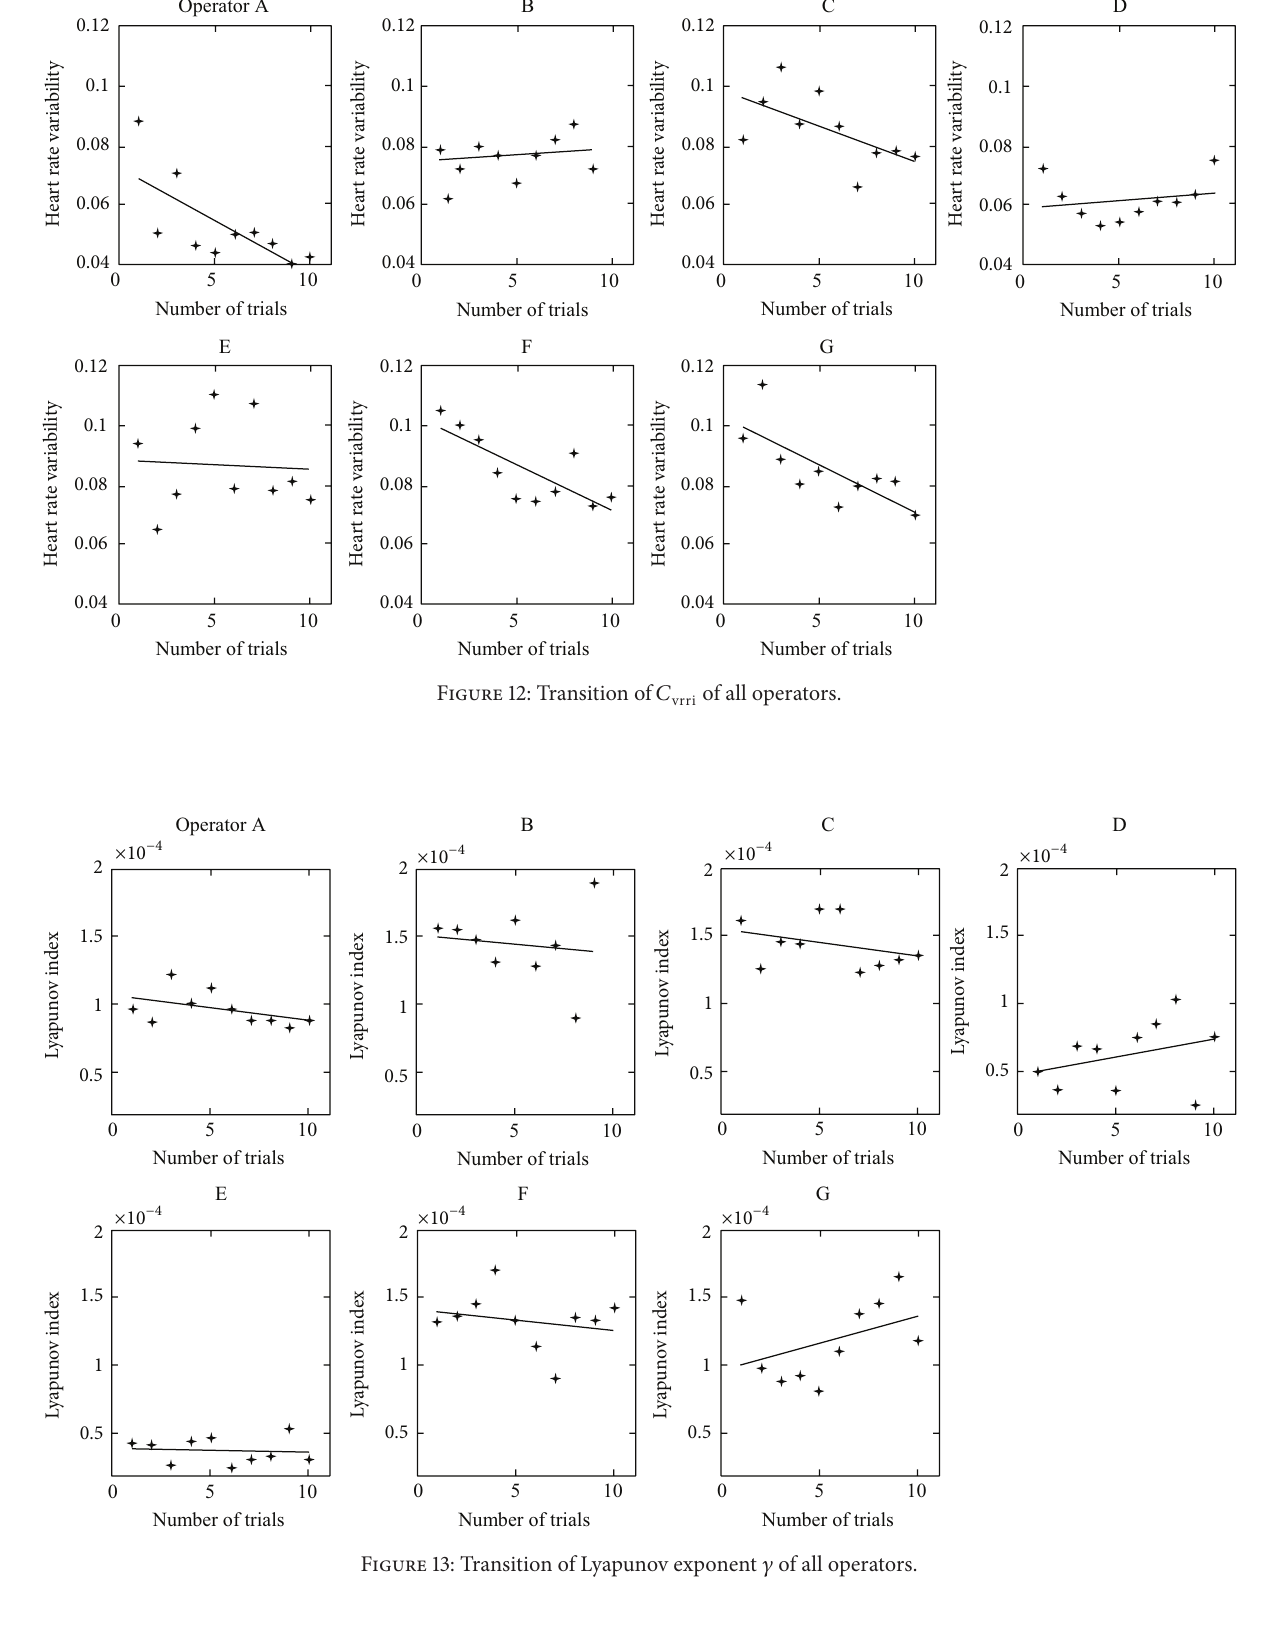
Figure 13: Transition of Lyapunov exponent 𝛾 of all